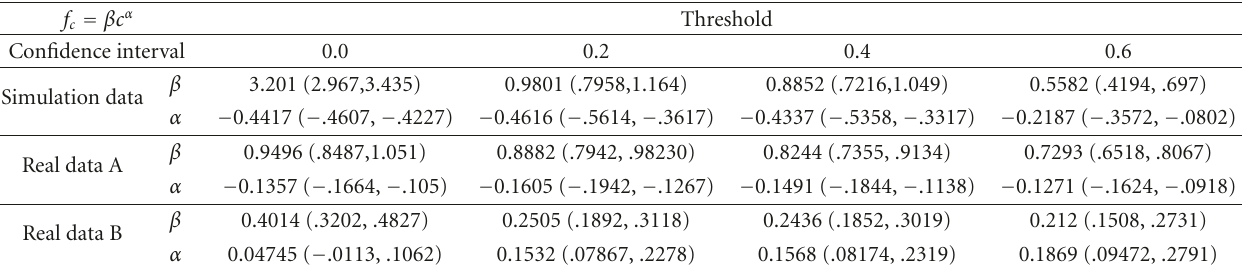
Table 4: Confidence intervals for parameters of clustering versus degree power law (confidence level = 95%). f c = βc